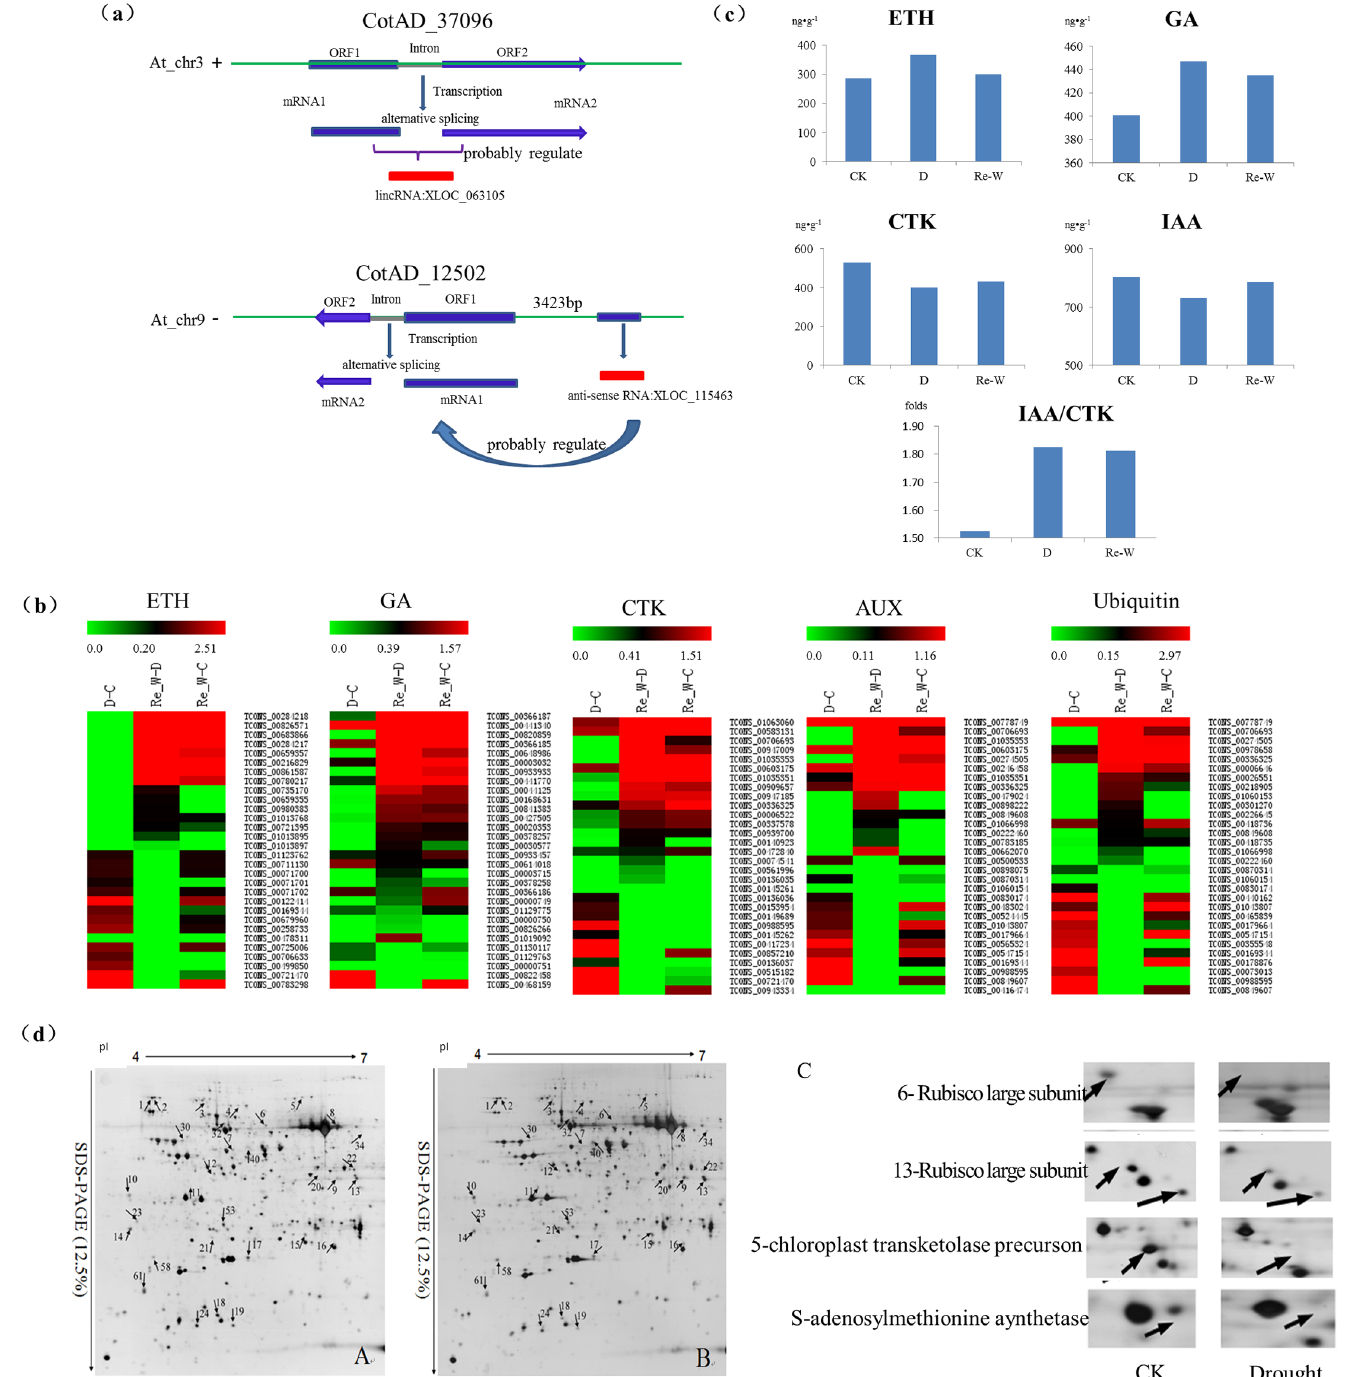
Fig 6. Regulation mechanism prediction of functional lncRNAs predicted by cis -acting and tran s-acting and relative analysis. (a) Regulation mechanism prediction of functional lncRNA-targets predicted by cis -acting and trans -acting. (b) The expression analysis of 30 randomly selected lncRNAs associated with each kind of hormones. (c) The content variations of plant hormones under drought stress and re-watering treatment. (d) The 2-DE image of total protein in leaves of ZhongH177 at trefoil stage and several differentially expressed proteins were enlarged. A represents proteins in ZhongH177-CK, B represents ZhongH177-Drought and C represents the enlargement of differentially expressed proteins.